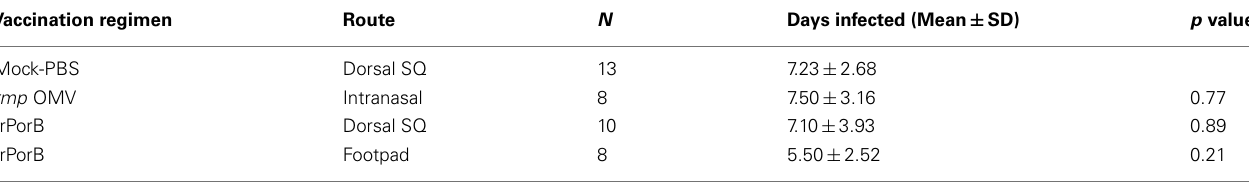
Table 1 | Immunization with OMV or rrPorB fails to protect female mice from genital infection by FA1090. Vaccination